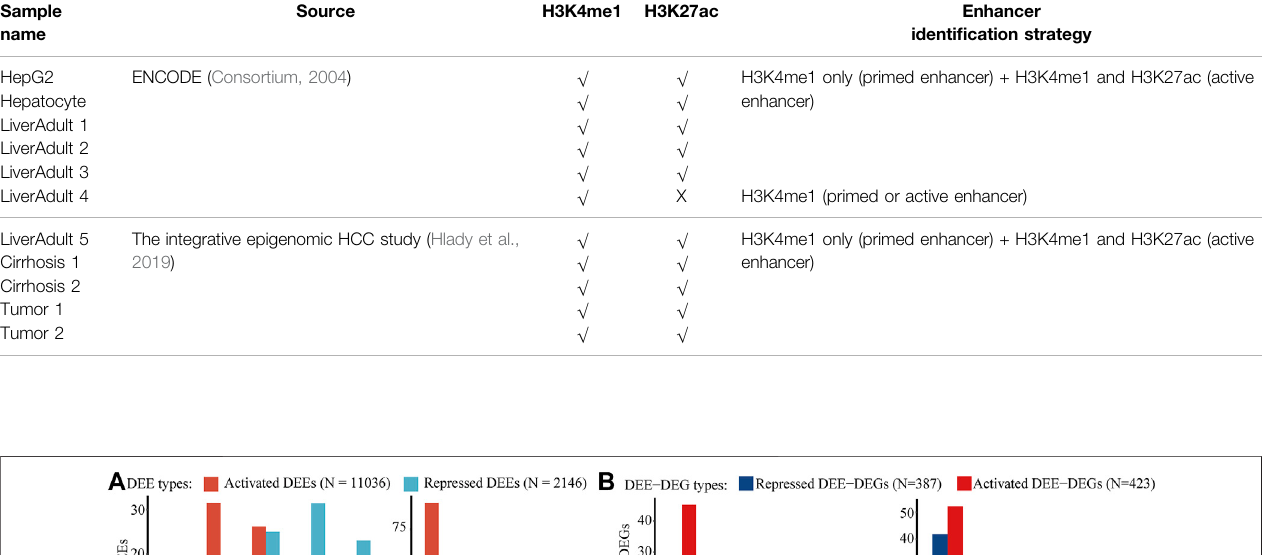
Frontiers in Cell and Developmental Biology |